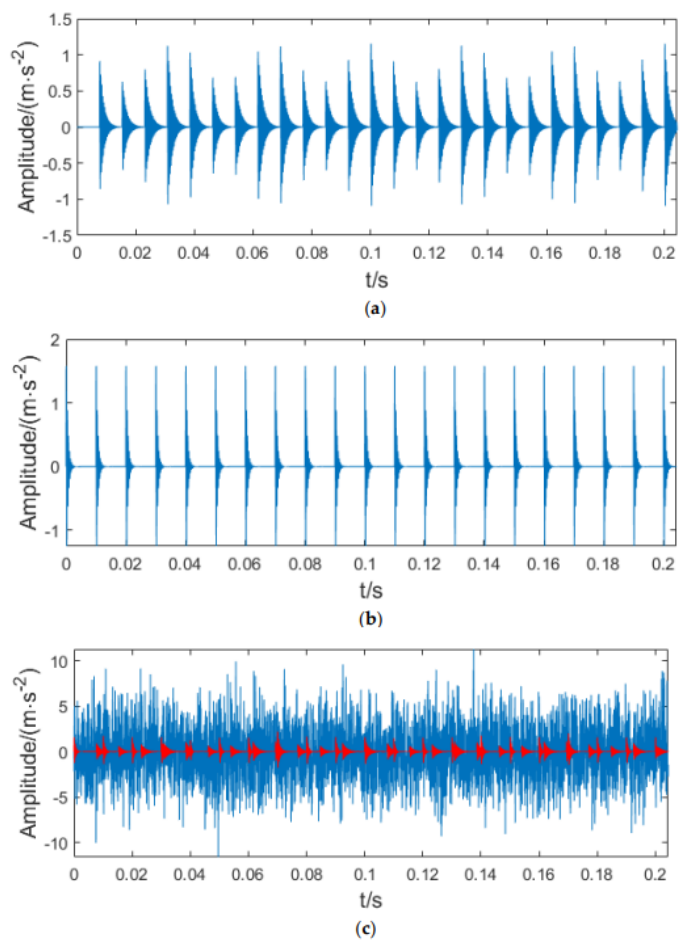
Figure 2. Simulated composite fault signal time-domain diagram. (( a ) The time-domain diagram of inner ring fault signal. ( b ) The time-domain diagram of outer ring fault signal. ( c ) The time-domain diagram of noise-added composite fault signal.)